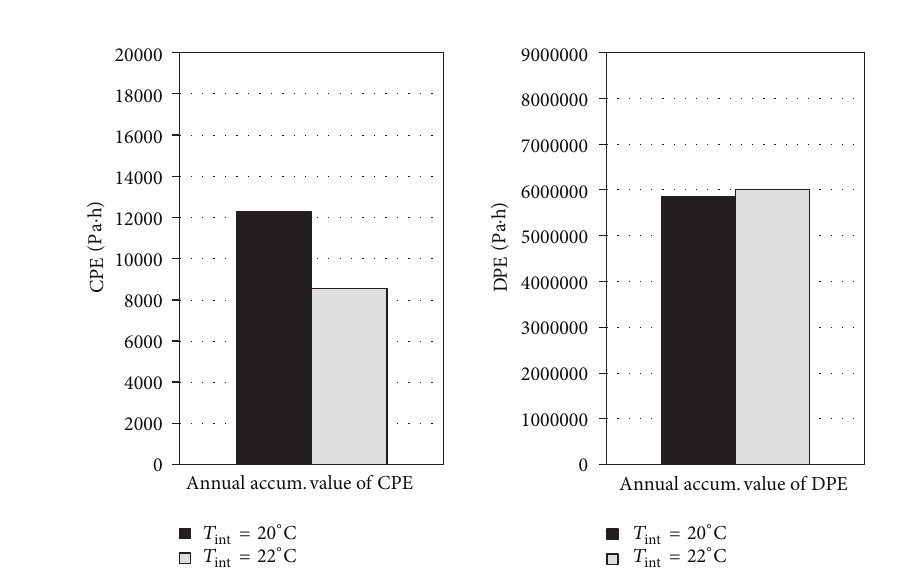
Figure 21: Exterior climate: rain.